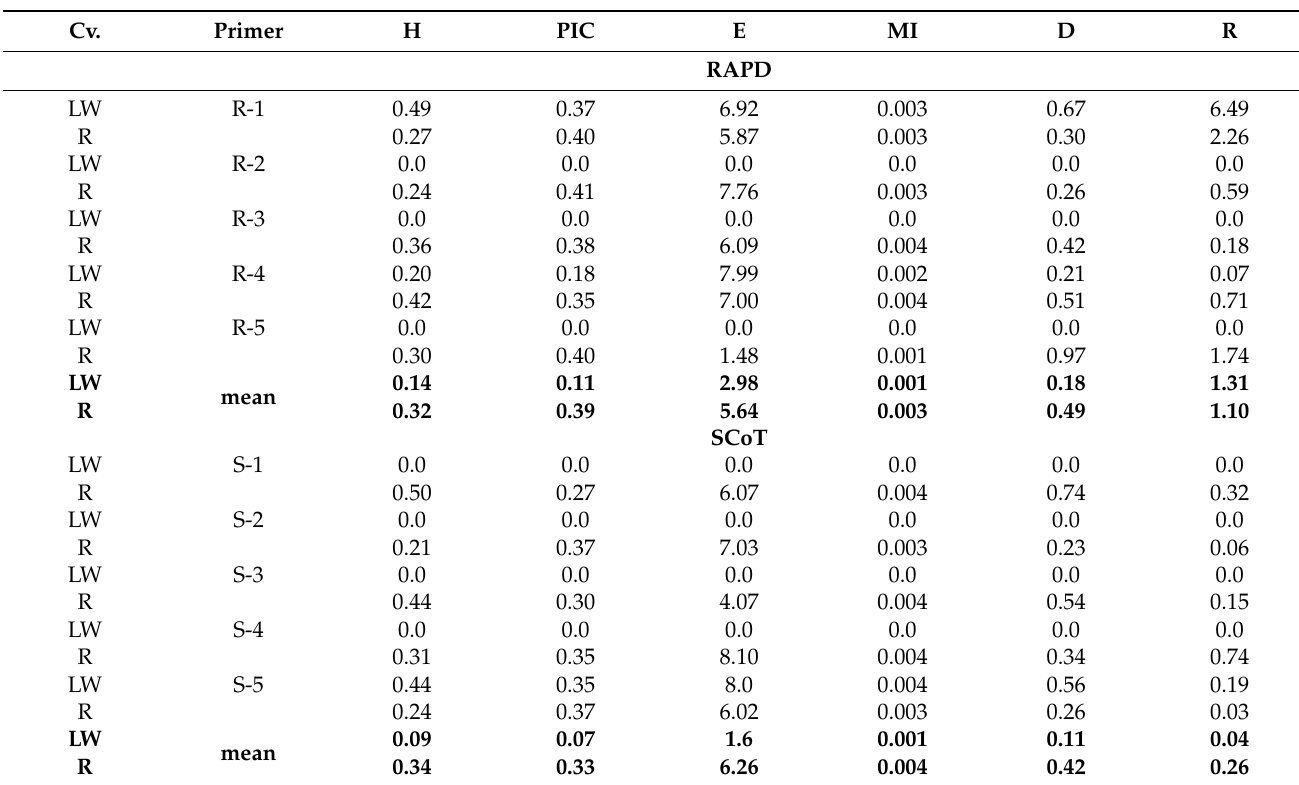
Table 5. Values of Heterozygosity index (H), Polymorphic Information Content (PIC), Effective multiplex ratio (E), Marker Index (MI), Discriminating power (D), and Resolving power (R) of the marker systems used in the